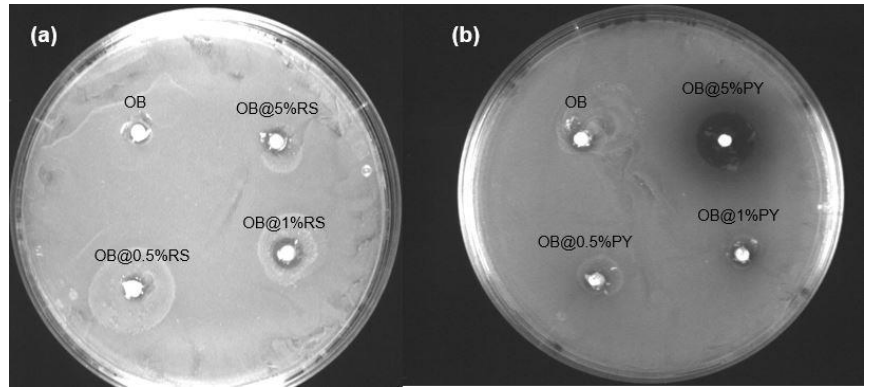
Figure 1. Agar diffusion tests with the different materials. ( a ) Control group (Obturys “OB”) and the sealer modified with different concentrations of resveratrol (OB@RS); ( b ) control group (OB) and the sealer modified with different concentrations of pyrogallol (OB@PY).